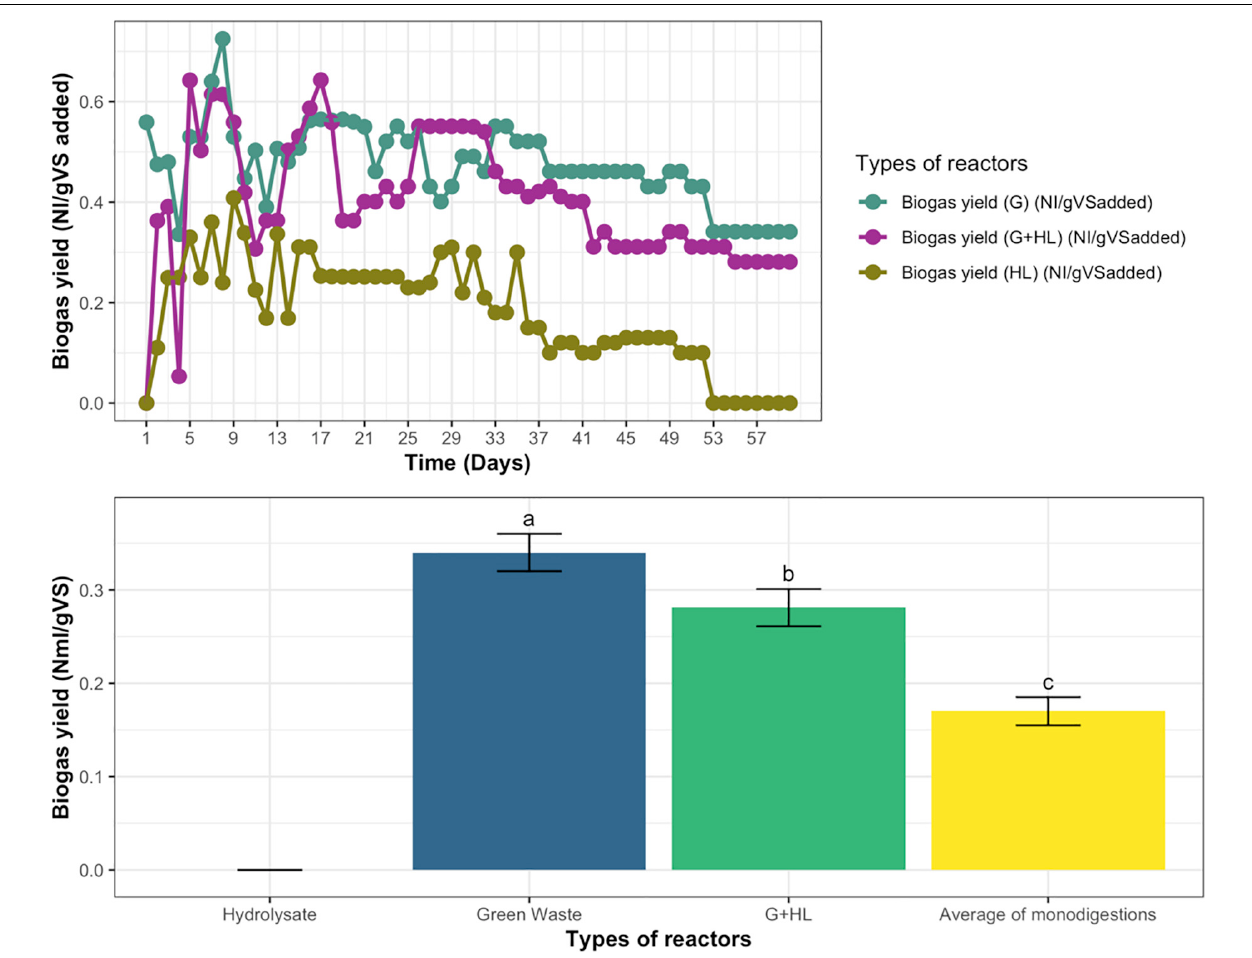
FIGURE 5 | (A) Daily Biogas yield of hydrolysate (HL), green waste (G), and their co-digestion (G+H). (B) Biogas yield of co-digestion compared with an average of mono-digestions for continuous anaerobic fermentation. Means having the same letter are statistically similar as per the Tukey test at p < 0.05.